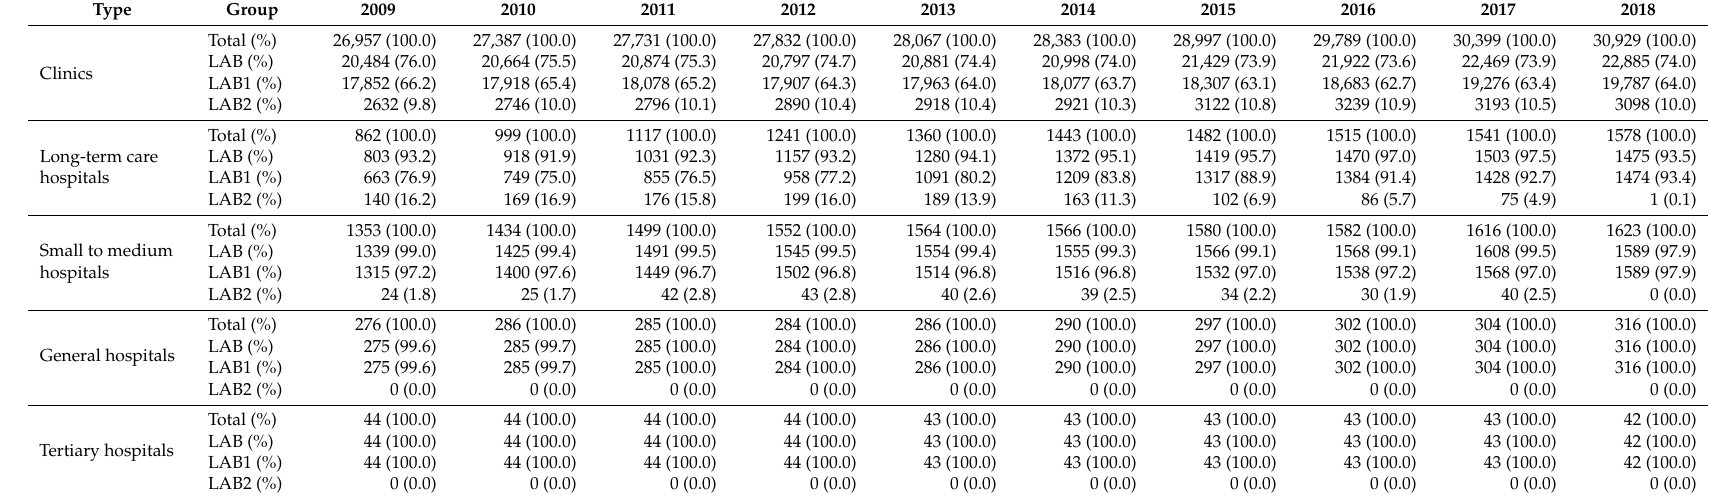
Table 1. The number of medical institutions according to the laboratory complexity